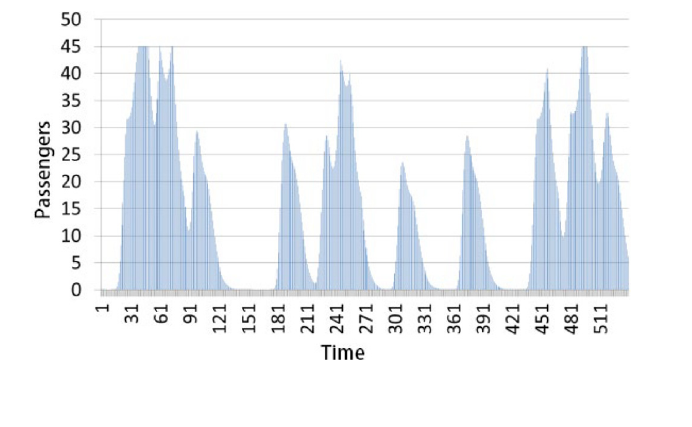
Table 2. Accuracy comparison of passenger demand predication